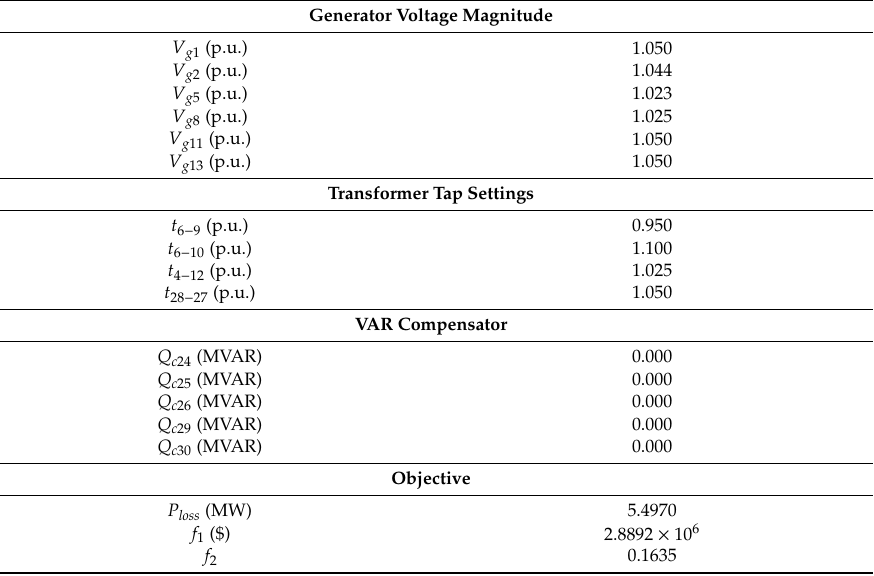
Table 2. Control variables and objectives under initial